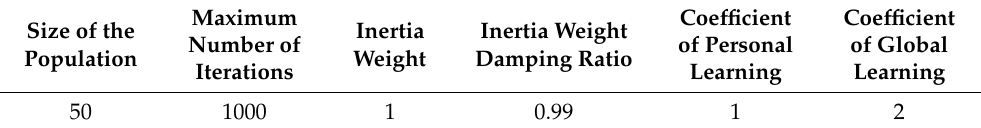
Table 3. Features of the model parameters that was used in the ANFIS-PSO model training and